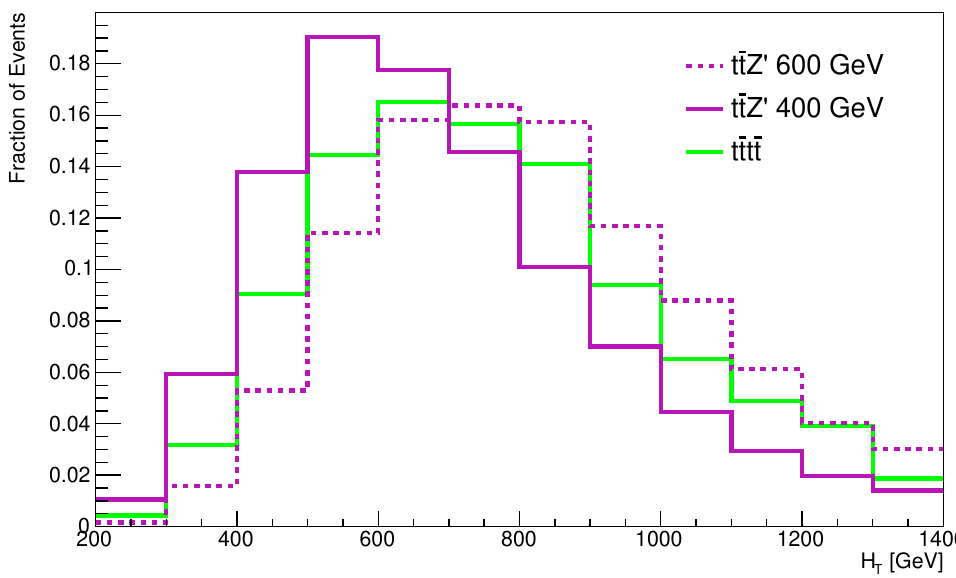
Figure 9 . H T kinematic distribution for events belonging to the global analysis selection.